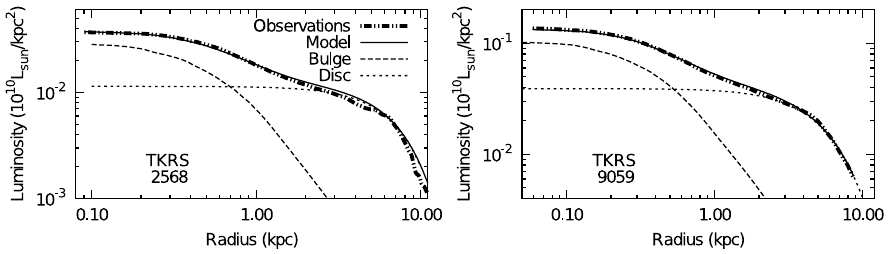
Fig. 2. Results of photometric modeling for the z (cid:12)lter.